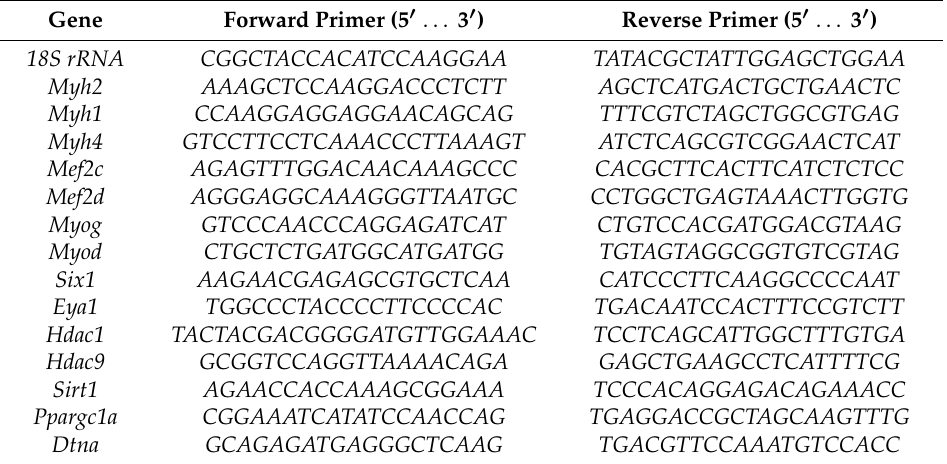
Table 1. Primers used for